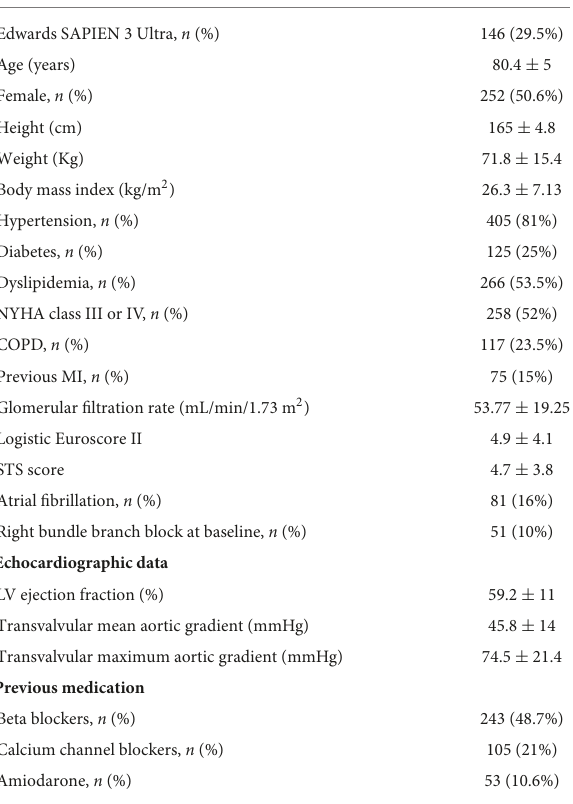
TABLE 1 Baseline